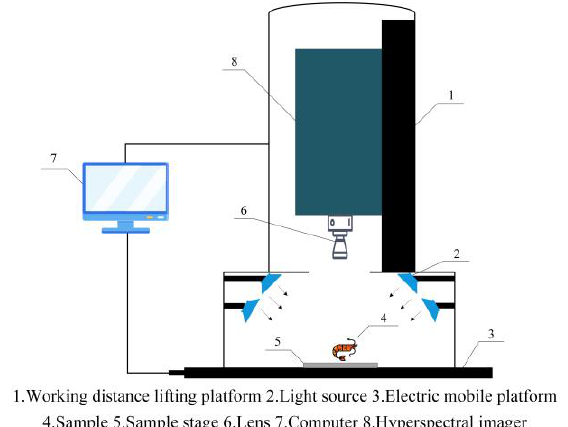
Figure 1. Structure diagram of main components of hyperspectral imaging system.